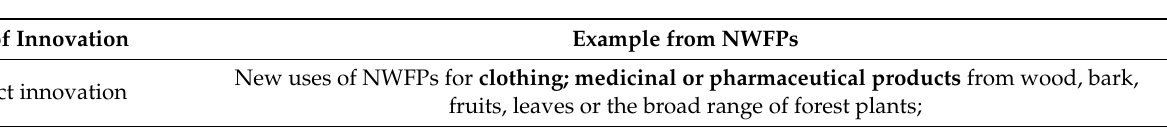
Table 6. Types of innovation with NWFP examples that can support bioeconomy (adapted from [70] (p.